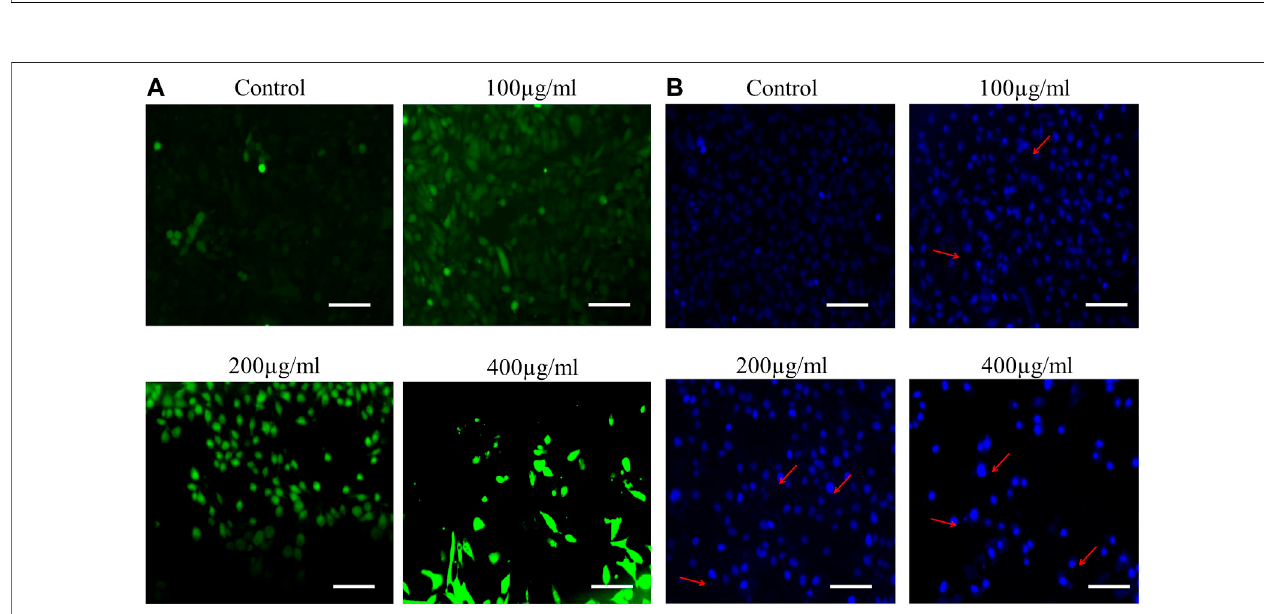
FIGURE2| Effect ofAOEonthe growth ofA549lung cancercells. (A) Percent(%) cellviabilityofA549cells after AOE treatment at concentrationsof100 – 400 μ g/ mlafter24 h. (B) Phase-contrastimagesofAOE-treatedA549cellsfor24 h.Datacommunicatedconstitutesthemean±SEMofindividualexperimentsperformedthrice in triplicate. The level of signi fi cance among different AOE-treated groups was determined using one-way ANOVA and Dunnett ’ s post-hoc in comparison with the untreated control where *represents p < 0.05, *** p < 0.001; Scale bar = 100 μ m, and magni fi cation = 20X